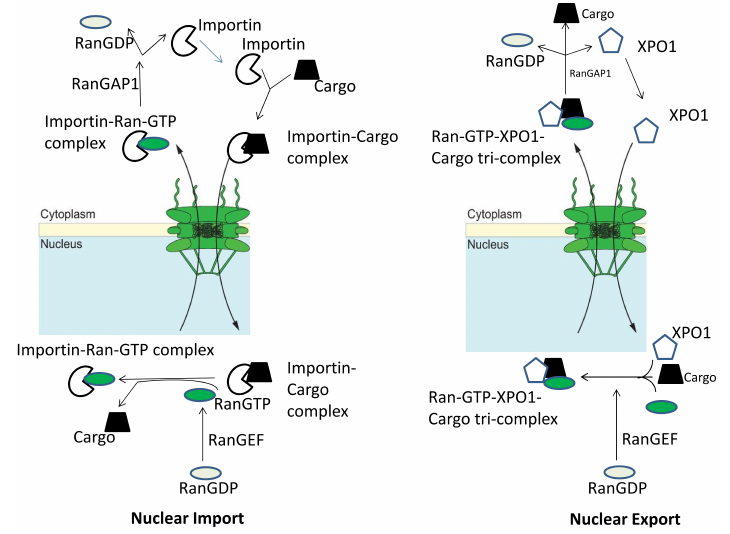
Figure 1. Nuclear transport machinery. An import complex consisting of a nuclear localization signal (NLS)-bearing cargo and an Importin is formed in the cytoplasm. After translocation through the nuclear pore complex, Ran-GTP displaces the cargo from the importin, resulting in nuclear cargo release. The importin–Ran-GTP complex returns to the cytoplasm through the Nuclear Pore Complex (NPC) where the Ran GTPase-activating protein (RanGAP1) stimulates GTP hydrolysis, releasing the Nuclear Transport Receptor (NTR) for another import cycle. Nuclear export cycles require the formation of a trimeric cargo–XPO1–Ran-GTP complex in the nucleus. After NPC passage, this complex